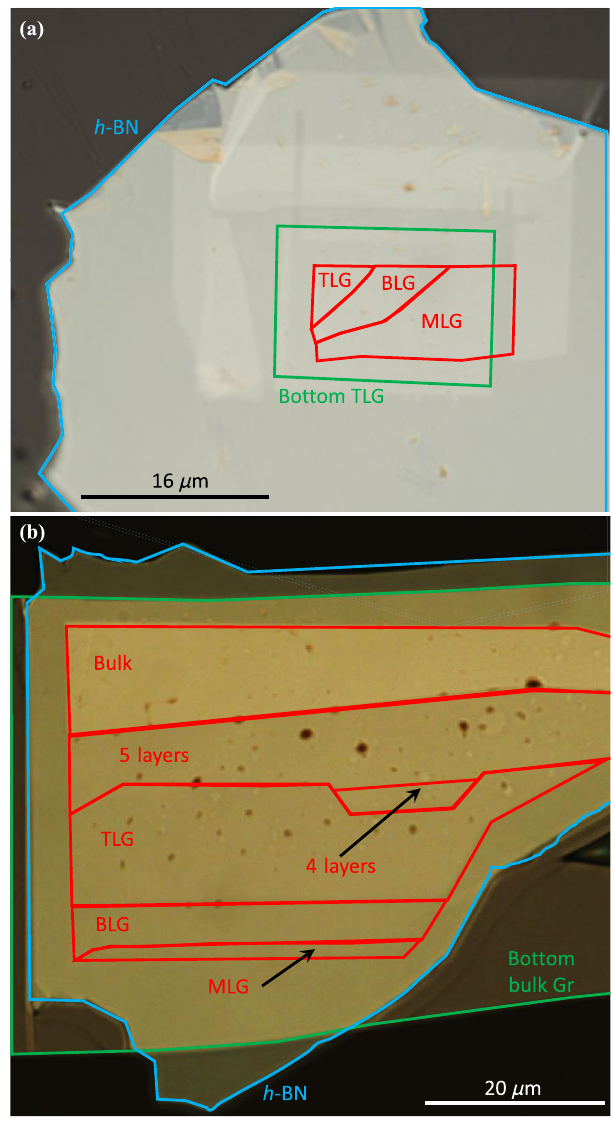
FIG. 6. Optical images of the studied terraced graphene samples. (a) The sample measured in Figs. 2(a) – 2(c) (twist angle of approximately 0.66°) with h -BN, bottom trilayer graphene, and top mono-, bi- and trilayer graphene regions indicated by blue, green, and red contours, respectively. (b) The sample measured in Figs. 2(d) – 2(f) (twist angle of approximately 0.1°) with regions indicated by similar colors. The top layer has bulk (estimated to be 18 layers), five layers, four layers, TLG, BLG, and MLG regions as indicated.